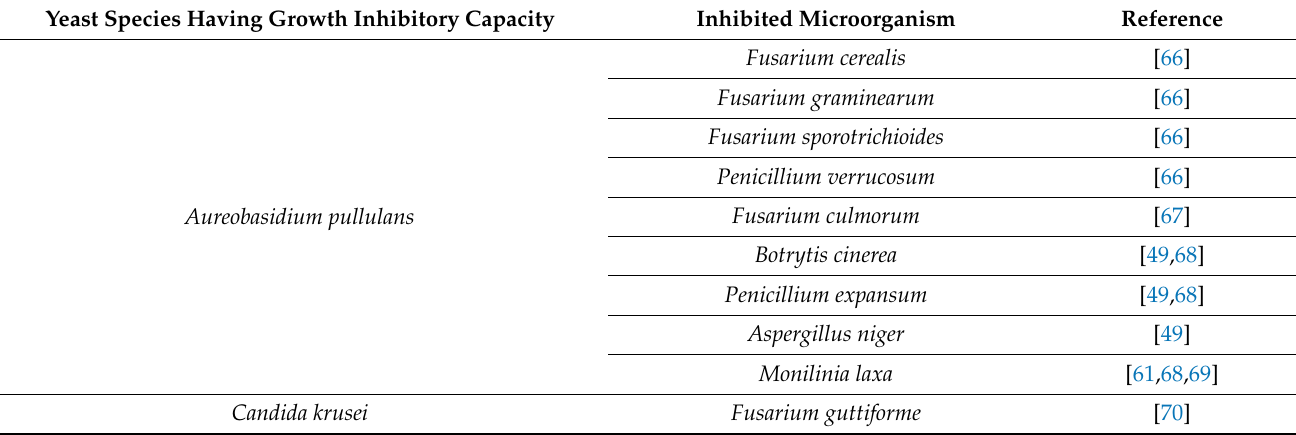
Table 1. Antagonistic yeast species.